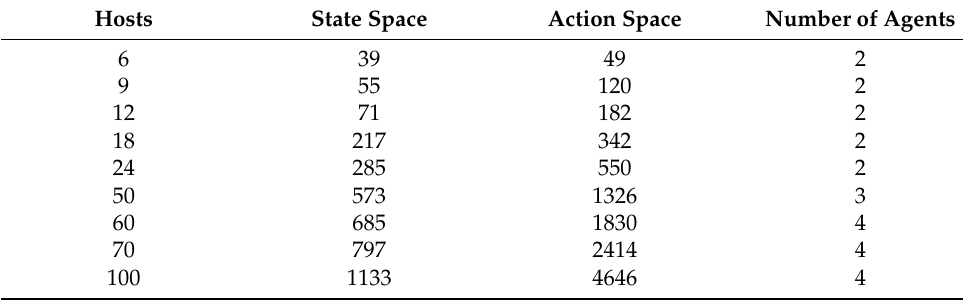
Table 1. Configurations of tested scenarios.